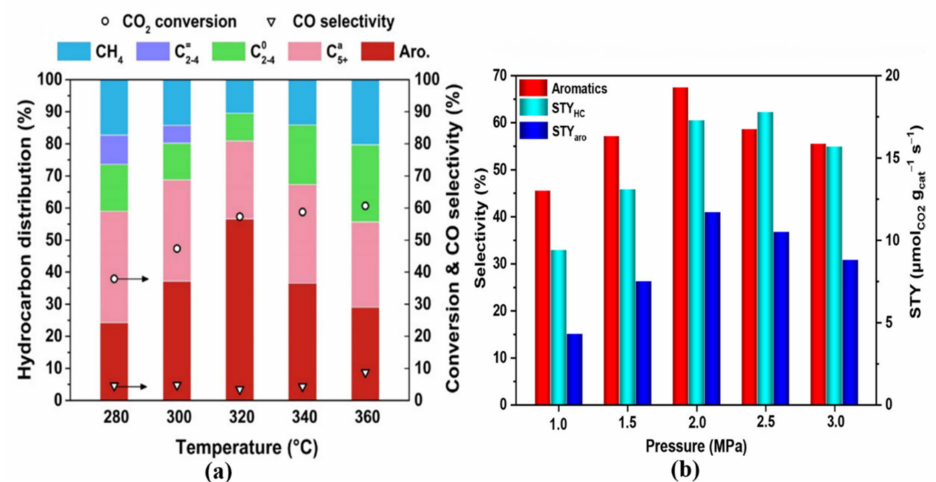
Figure 16. ( a ) Effects of the reaction temperature on the catalytic performance over 6.25Cu- Fe 2 O 3 /HZSM-5-c catalysts. Reaction conditions: 320 ◦ C, 3.0 MPa, GHSV = 1000 mL · g cat–1 · h –1 , H 2 /CO 2 /N 2 = 72/24/4, 2 g tandem catalysts. Reprinted with permission from Song et al. [115]. Copyright (2020) American Chemical Society. ( b ) Effects of the reaction pressure on the aromatic se- lectivity, STY HC , and STY aro over the FeK1.5/HSG|HZSM-5(50) catalysts. Other reaction conditions: 340 ◦ C, H 2 /CO 2 = 3, 150 mg of FeK1.5/HSG and 150 mg of HZSM-5(50), TOS = 24 h. Reprinted with permission from Wang et al. [112]. Copyright (2019) American Chemical